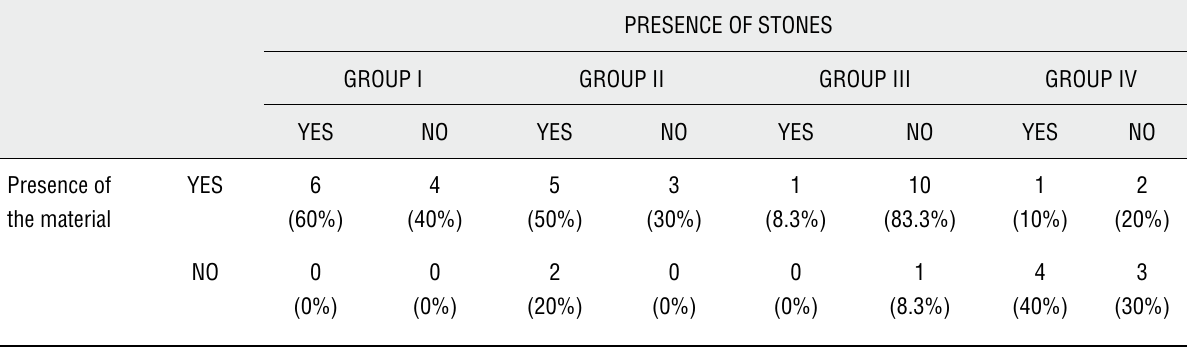
Table 2 - comparison of the presence of the material and the presence of stones at the moment of euthanasia in the 4 studied